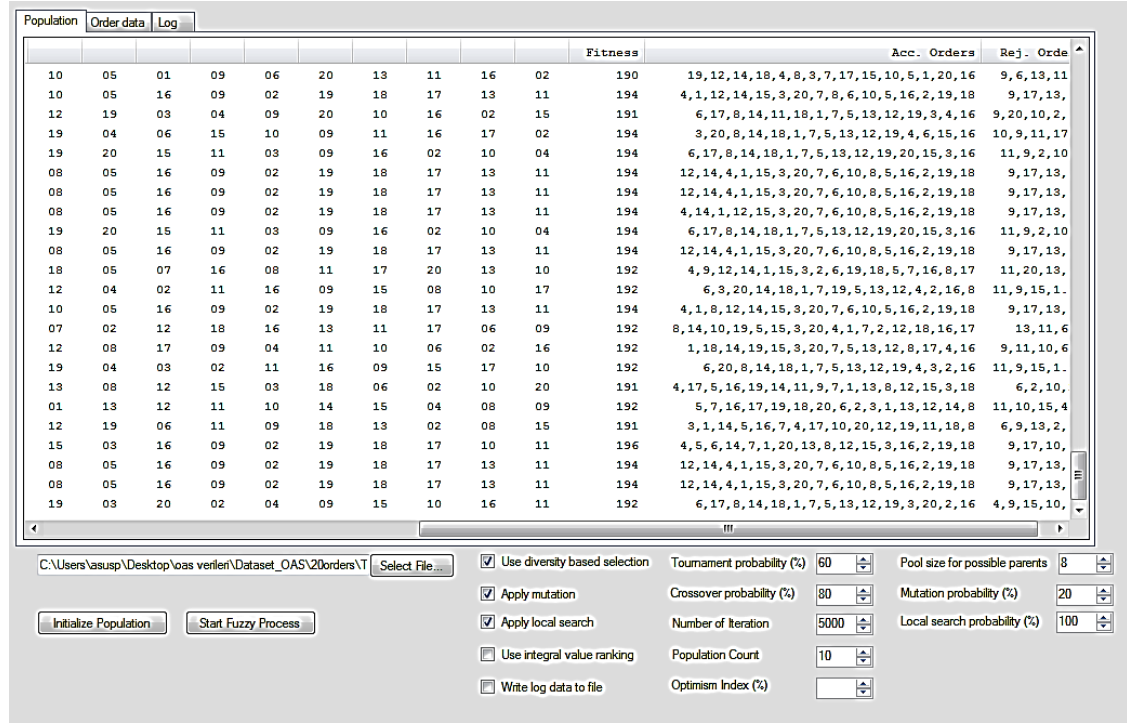
Figure A5. Solution screen with signed distance method for instance